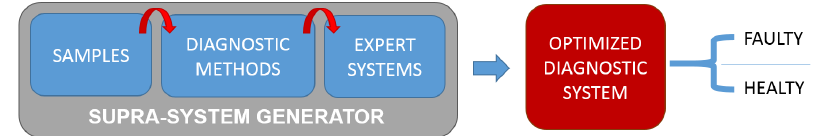
Figure 5. General scheme of the supra-system, the system generator of optimized fault diagnostic system.